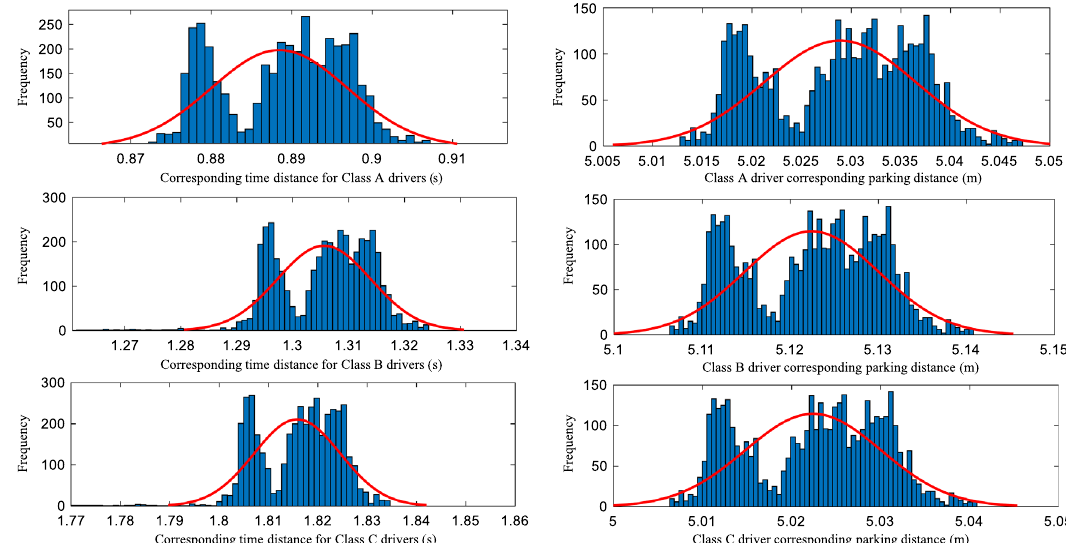
Figure 10. Frequency histograms of the feature parameters corresponding to the three types of feature drivers.